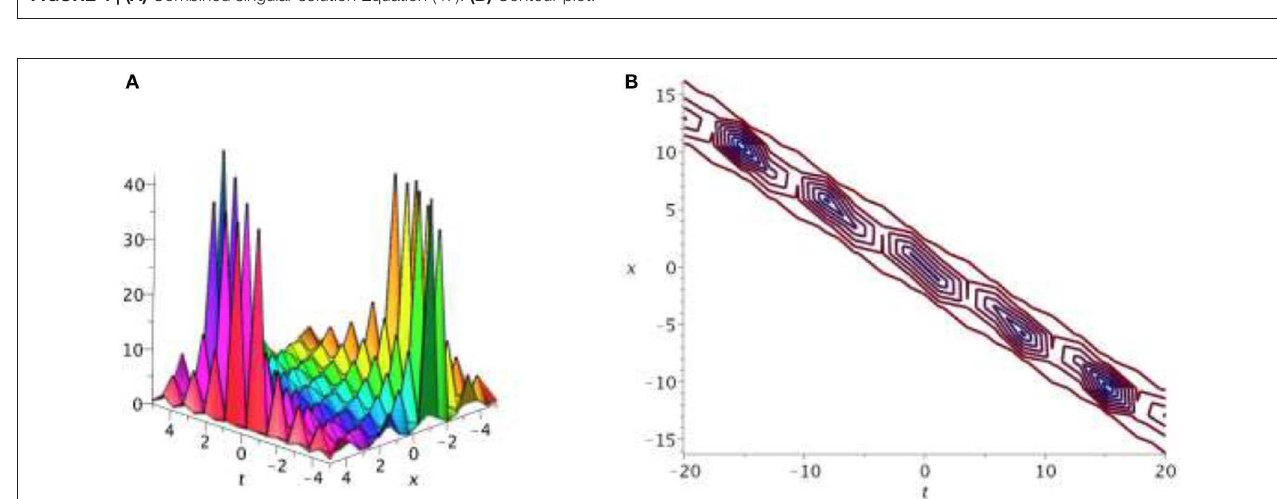
FIGURE 5 | (A) Singular periodic soliton Equation (50). (B) Contour plot.